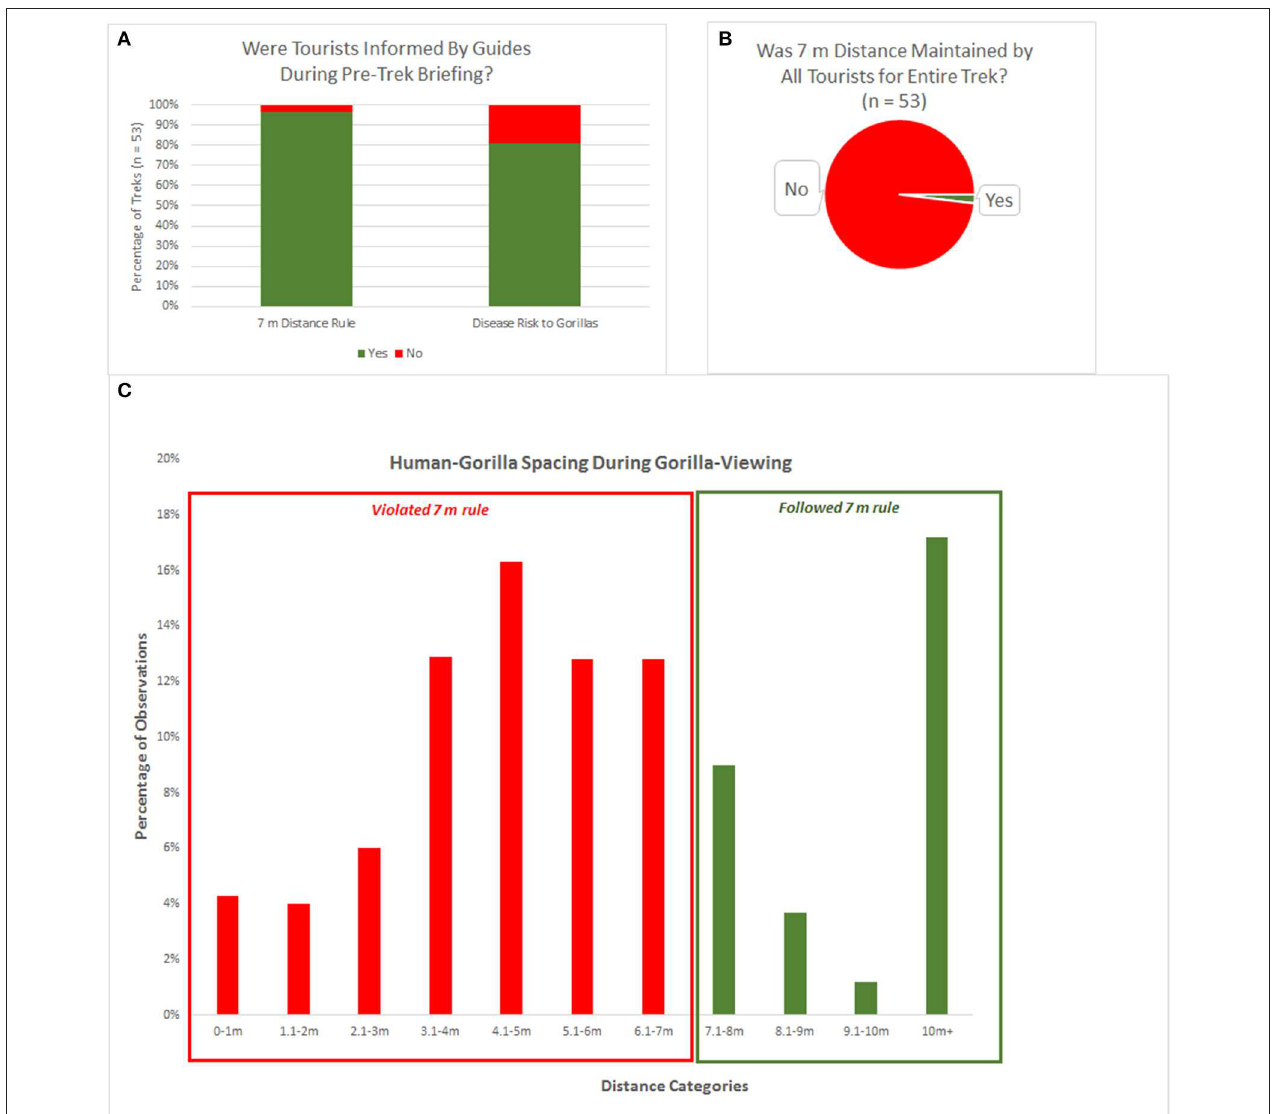
FIGURE 2 | Rule adherence information and behavior during gorilla viewing. (A) Percentage of treks in which tourists were informed by guides of the 7m rule and the importance of maintaining that distance to protect gorillas from disease transmission. (B) Percentage of treks with rule adherence vs. violations ( n = 53 treks). (C) Observations of nearest human-gorilla spacing collected at 2min intervals, shown by distance